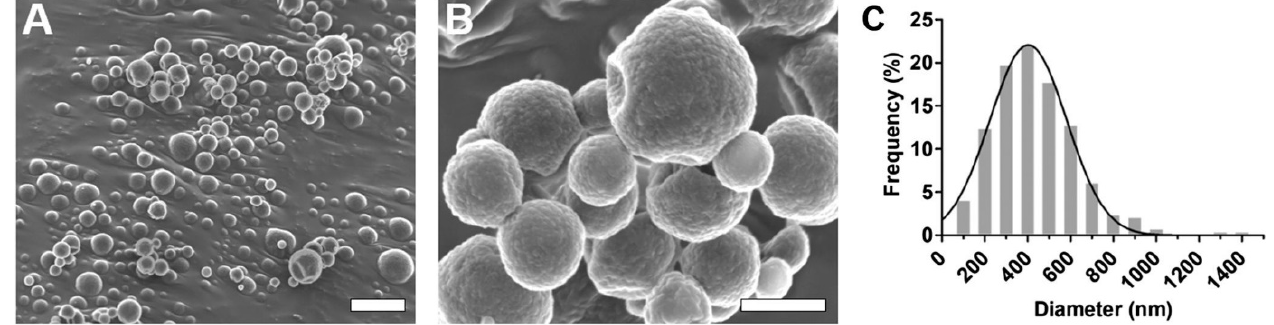
Figure 3. Representative SEM images of TDF/FTC-NPs at the magnifications of ( A ) 15,250× (bar = Figure 2 µm) and ( B ) 100,000× (bar = 0.5 µm). ( C ) Particle diameter distribution determined by SEM and corresponding Gauss fitting [82]. Reproduced with permission from Elsevier (Copyright©2019).